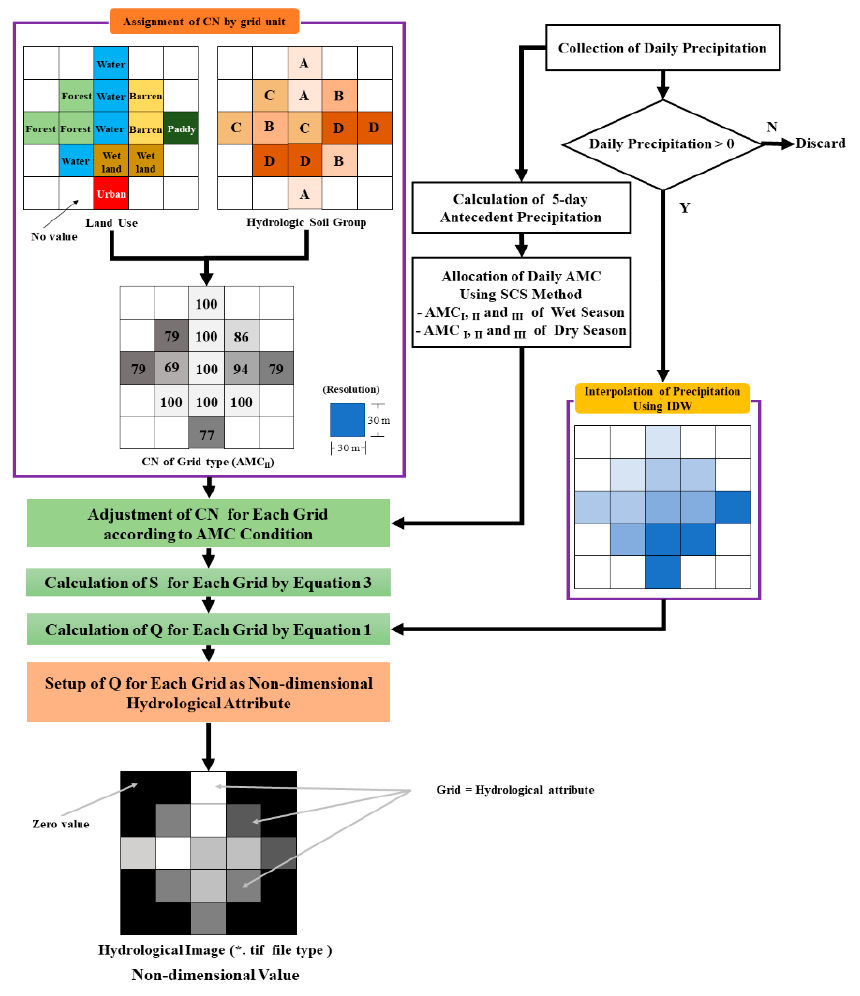
Figure 3. Schematic of building process of hydrological image.